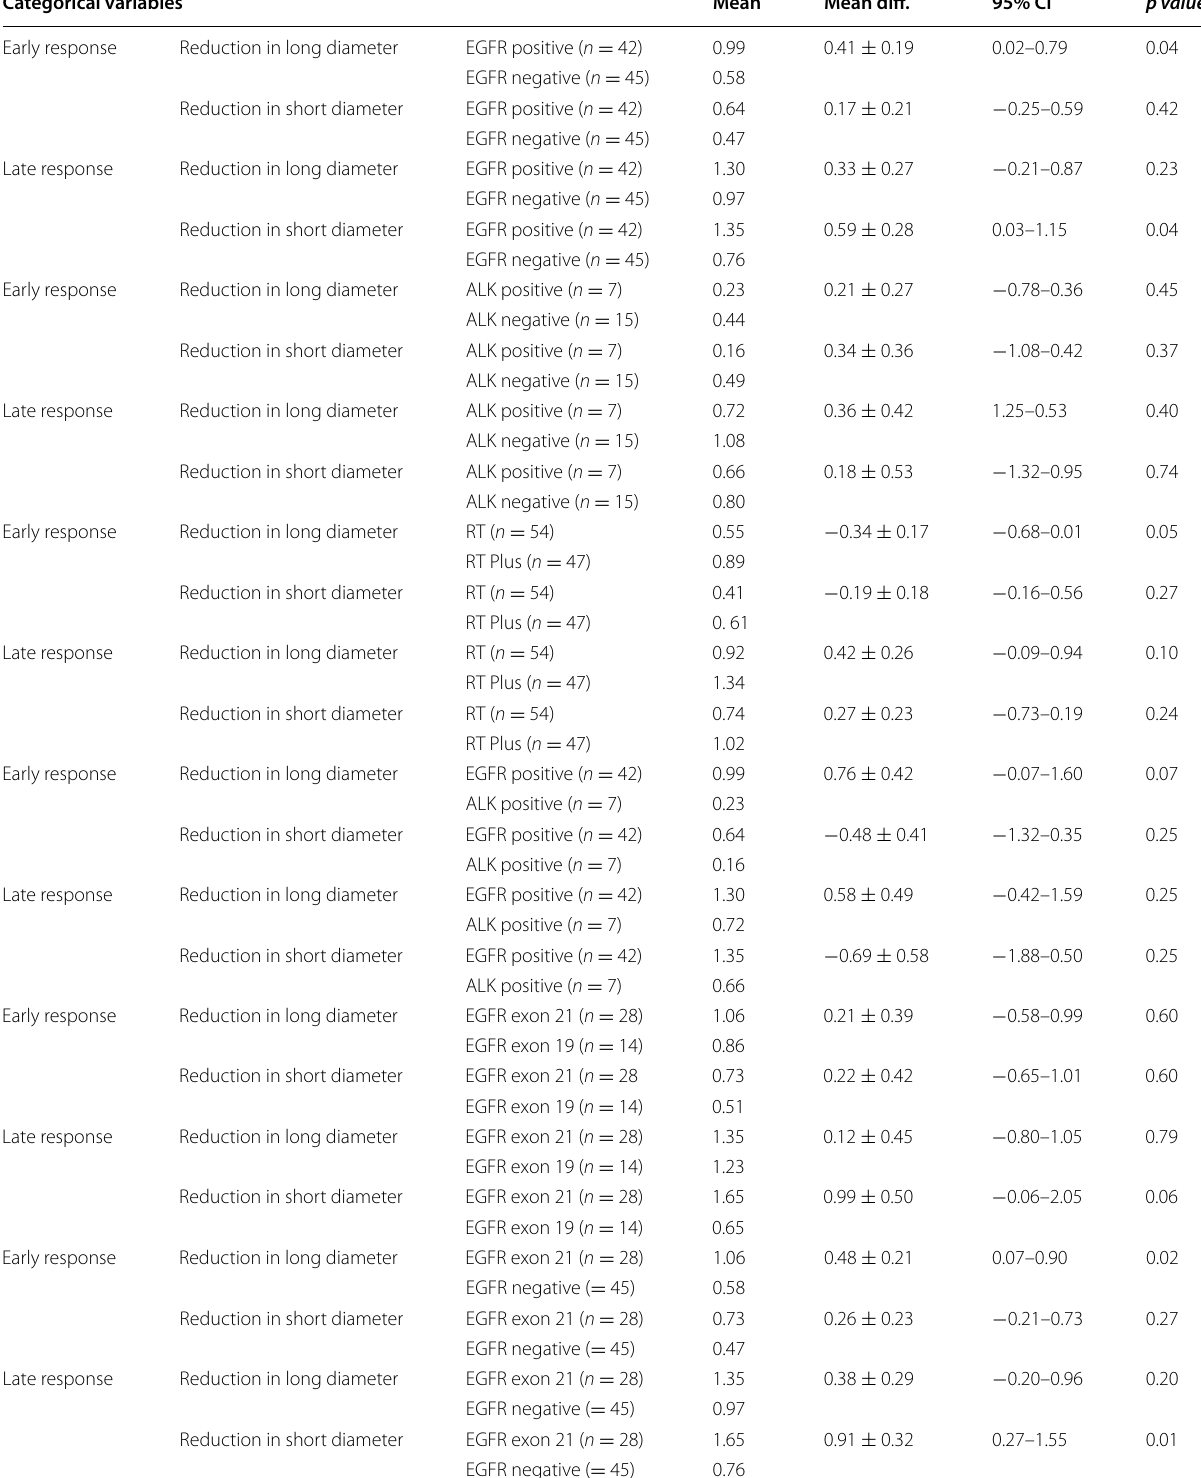
Table 2 Outcome of thoracic radiotherapy based on EGFR expression, EML4-ALK rearrangement, and treatment modalities Categorical variables Mean Mean